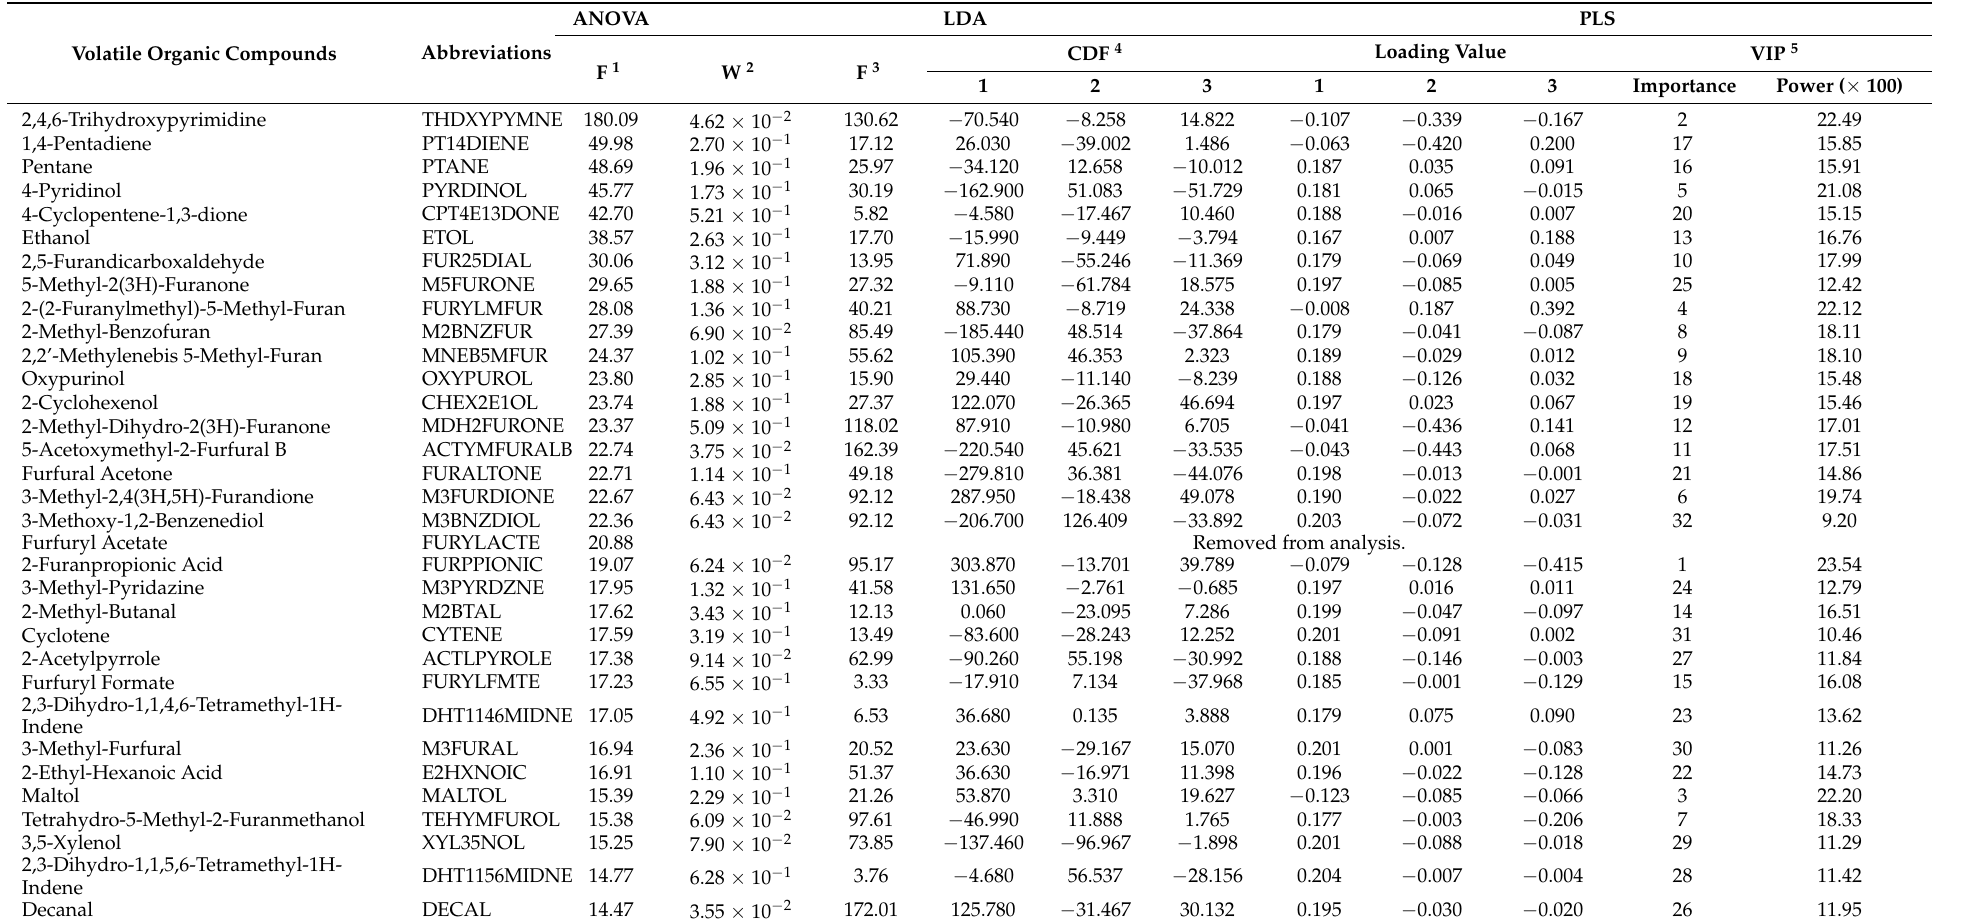
Table 1. LDA results after matrix reduction method to 20% of original dimension based on the VOCs with higher F values from One-way